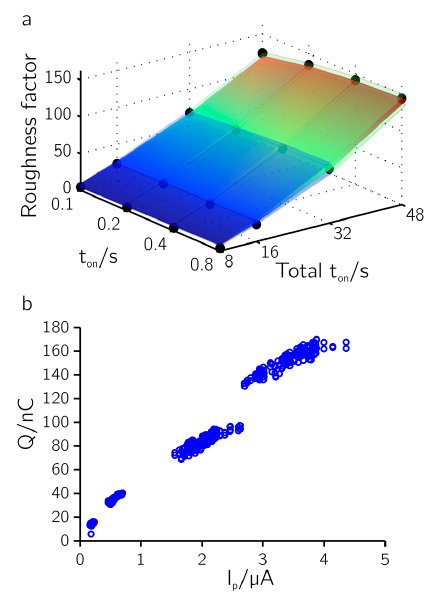
Figure 4. Pt black characteristics. ( a ) Roughness factor determined from integrating cyclic voltammograms (CVs) in H 2 SO 4 from all electrodes of one chip for different deposition parameters ( n = 64 electrodes per data point). Standard deviations are represented by semitransparent layers. ( b ) Integrated current from the hydrogen desorption region vs. maximum positive pulse height of the pulse train during deposition.